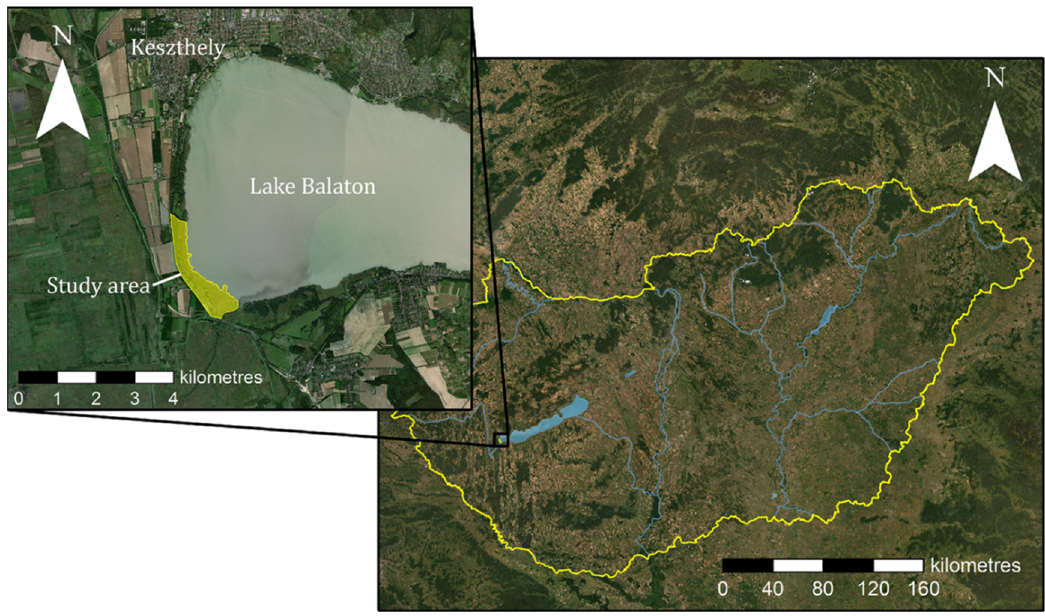
Figure 1. Location of the study area.